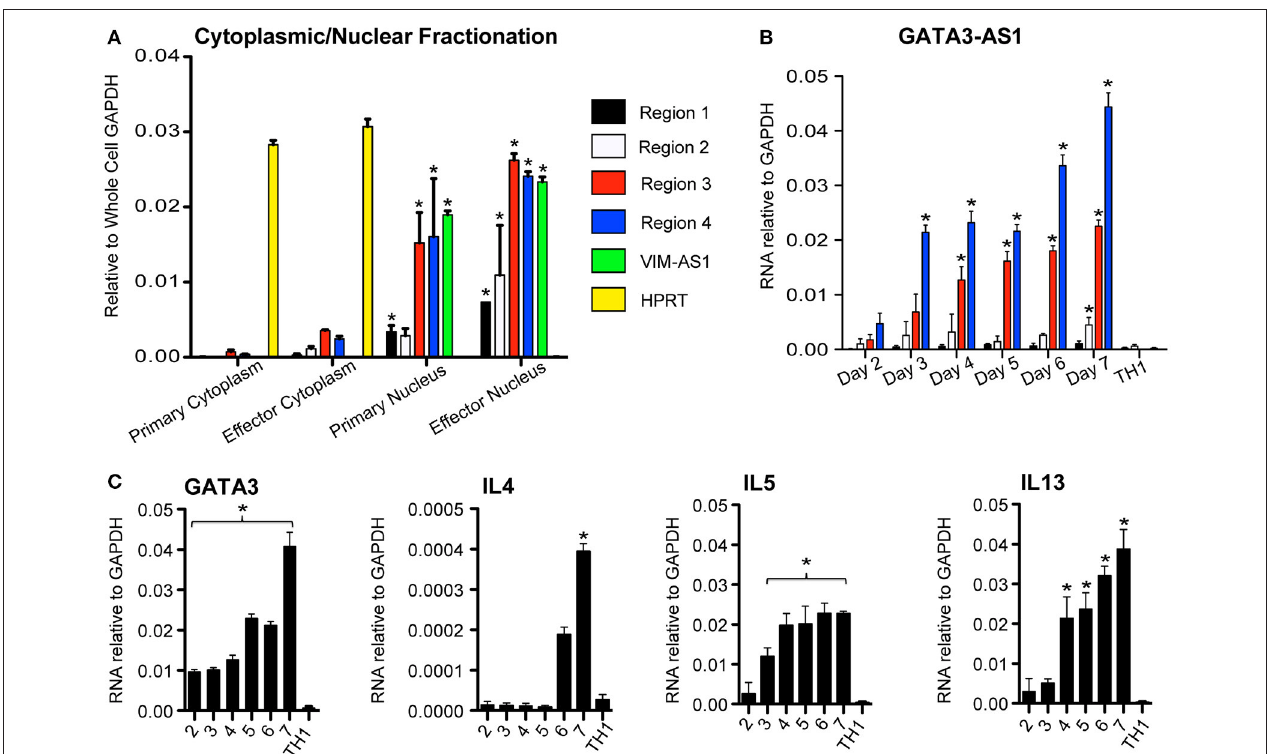
FIGURE 2 | GATA3-AS1 is localized in the nucleus and expression increases during TH2 cell polarization . (A) Cellular and nuclear fractions of primary and effector TH2 populations analyzed via qPCR. Values represent 11 CT vs. whole cell GAPDH . VIM-AS1 lncRNA is a nuclear control, while HPRT mRNA represents a cytoplasm specific control. Statistical significance vs. relative cytoplasmic fraction was determined by Students T-test ( n = 3). * P < 0.05 (B) Total PBMCs were cultured under TH1 or TH2 polarizing conditions, and RNA was isolated on consecutive days. Mean ± S.D. gene transcripts of GATA3-AS1 were quantified via qPCR and normalized to GAPDH . (C) Similar analyses were completed for GATA3, IL4, IL5, and IL13 . Statistical significance vs. TH1 effector cells on day 7 was determined by Students T -test ( n = 3). * P <